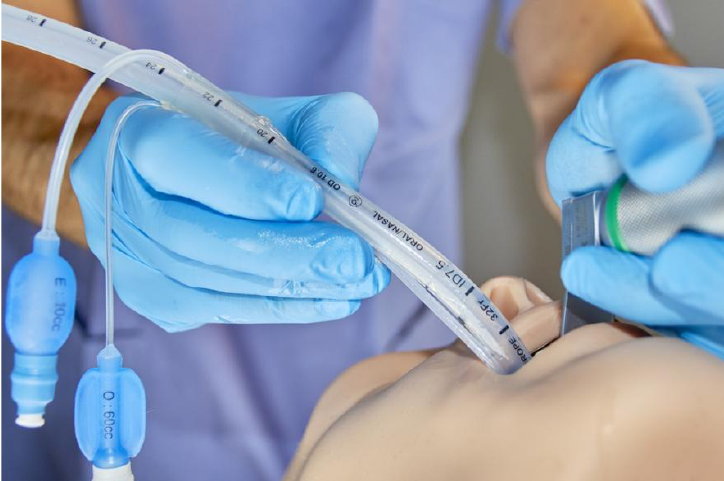
Figure 1. Spritztube details. The device, after insertion into the oral cavity, is stopped once the black marker on the Spritztube (teeth mark) reaches the upper incisors.